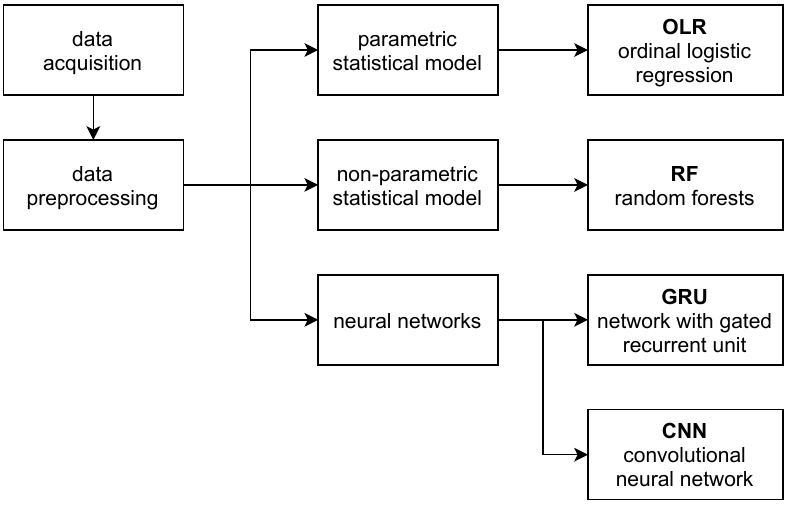
Figure 1. Scheme of data analysis and